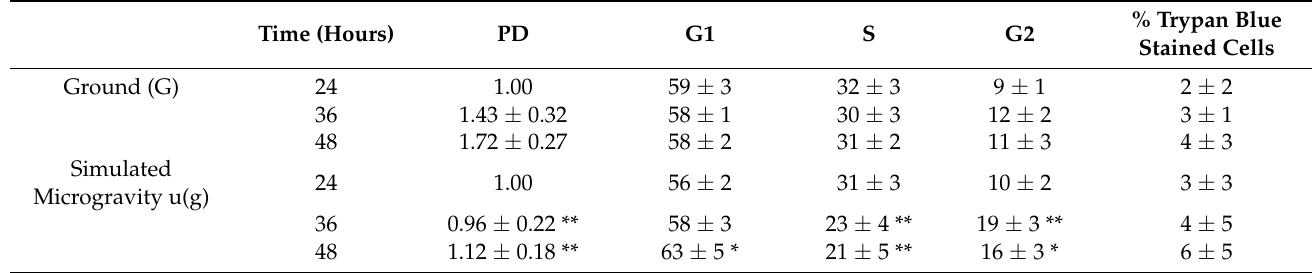
% Trypan Blue Stained Cells